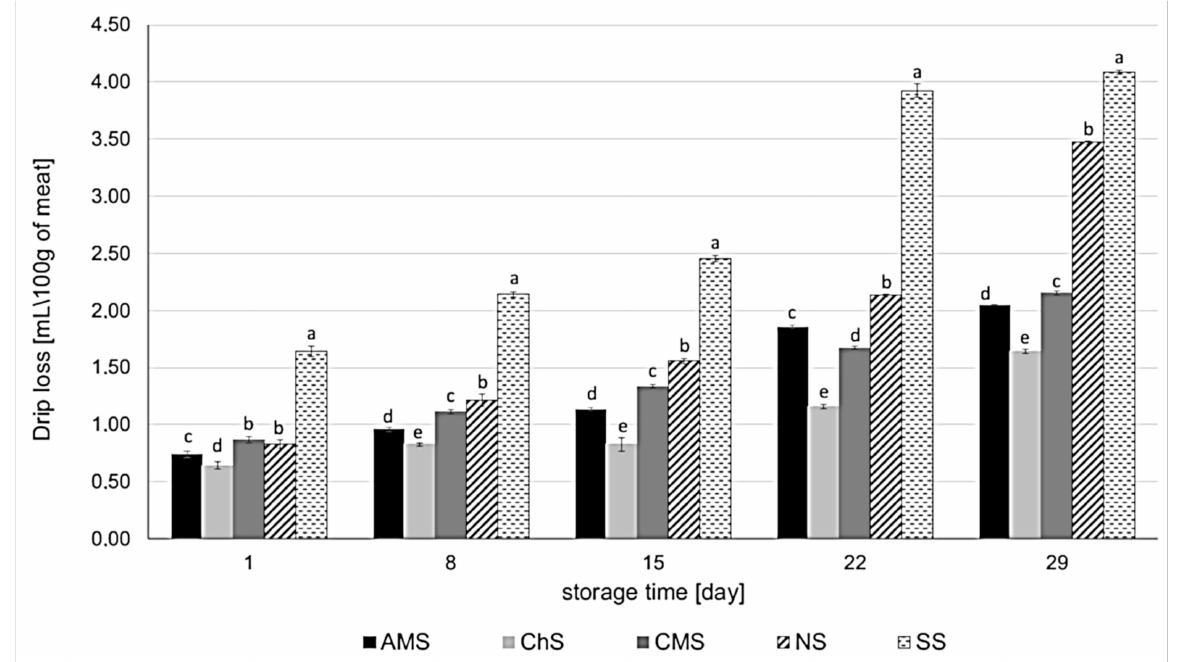
Figure 6. Effect of Aronia melanocarpa, Chaenomeles superba, and Cornus mas leaf extracts on drip loss in pork sausages stored in MAP at 4 ◦ C. The results are expressed as mean ± SD. a, b, c, d, e—statistically significant differences between the variants of sausages ( p < 0.05); AMS—sausage with Aronia melanocarpa leaf extract (5% v / w ); ChS—sausage with Chaenomeles superba leaf extract (5% v / w ); CMS—sausage with Cornus mas leaf extract (5% v / w ); NS—sausage with curing salt containing sodium nitrate (III); SS—control sausage with salt and spices only (without extract and nitrates